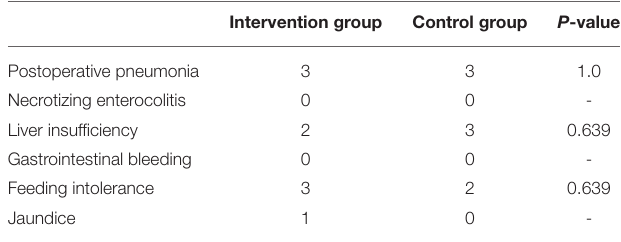
TABLE 4 | Comparison of complications between the two